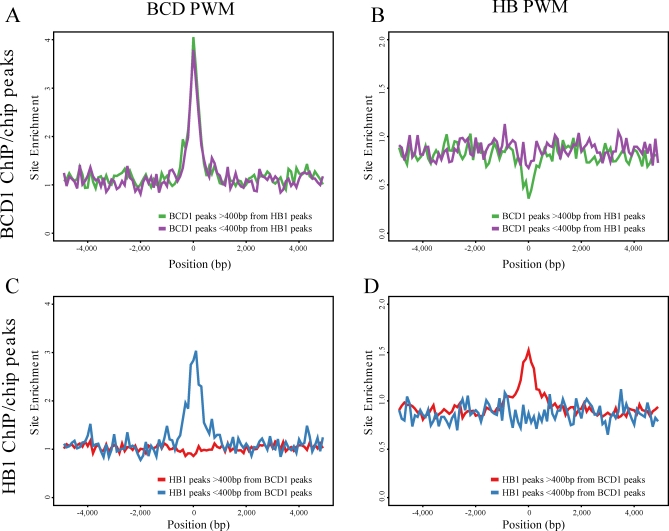
In Vivo Binding Is Influenced by a Context Determined by Other Factors(A) and (B) show the fold enrichment of BCD and HB PWMs in nonoverlapping windows of 100 bp across the 10-kb regions (±5 kb) around 1% FDR BCD1 peaks, divided into those less than and greater than 400 bp from HB 1% FDR peaks.(C) and (D) show the same analysis for 1% FDR HB1 peaks divided into those less than or greater than 400 bp from BCD1 1% FDR peaks. As (D) shows, HB recognition sequences are not enriched in regions bound by both HB and BCD, but are enriched in regions bound by HB and not by BCD.